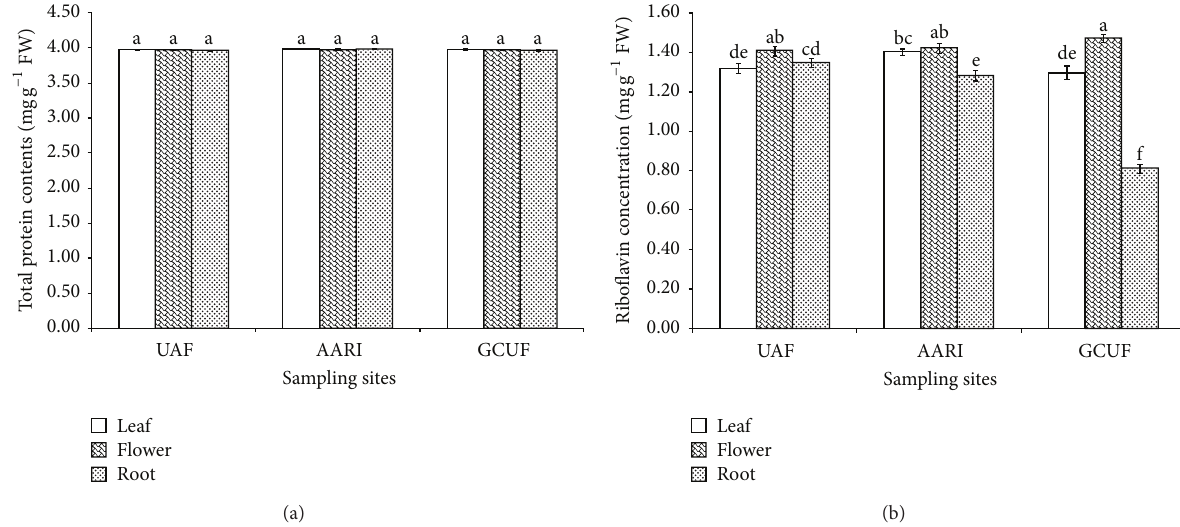
Figure 4: Total protein concentration (a) and riboflavin concentration (b) in different tissues of calendula plants collected from semiarid zone. Values ( 𝑛 = 9 ± SE) with different superscripts (a–f) are significantly different at 𝑃 < 0.05 .